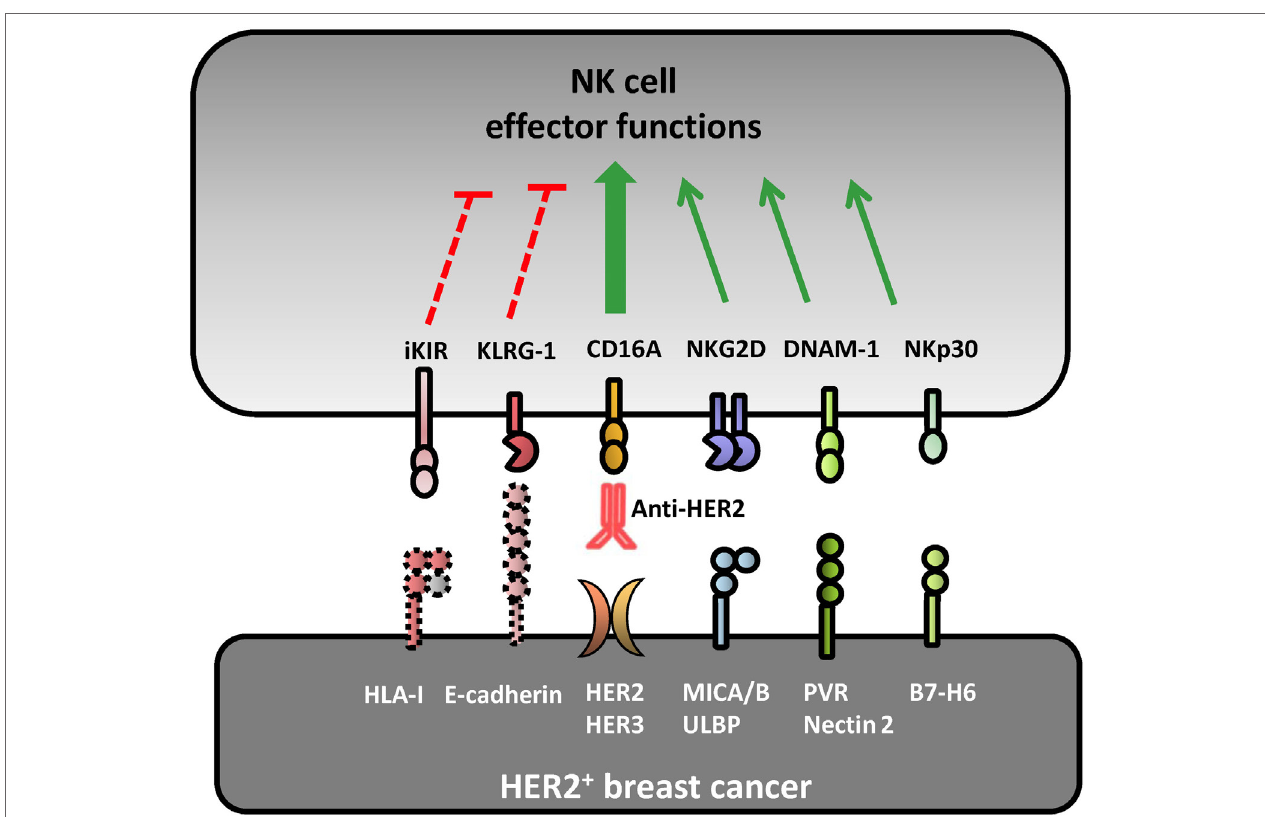
FiGURe 1 | Receptor–ligand pairs involved in natural killer (NK) cell recognition of HER2 + breast cancer cell lines. Several receptor–ligand pairs are involved in the crosstalk between breast cancer (BC) cells and NK lymphocytes. Natural cytotoxicity against HER2 + BC is mainly driven by NKG2D, DNAM-1, and NKp30 activating receptors upon interacting with their cognate ligands MICA/B, PVR/Nectin-2, and B7-H6, respectively. Human epidermal growth factor receptor 2 (HER2)- dependent downregulation of surface HLA-I expression impairs KIR-mediated inhibition facilitating NK cell recognition of BC cell lines. Anti-HER2 therapeutic monoclonal antibodies elicit a strong NK cell-mediated antibody-dependent cell-mediated cytotoxicity response against HER2 + BC cells upon interaction with the activating CD16A receptor. E-cadherin expression can be recognized by KLRG1 inhibitory receptor expressed by some NK cell subsets, modulating their direct and antibody-dependent